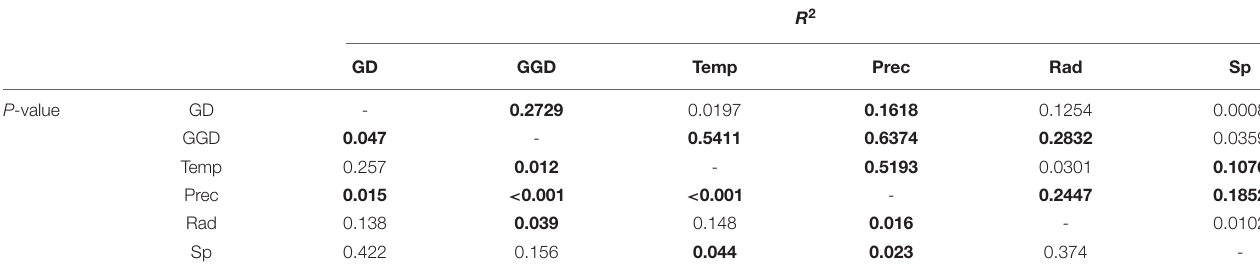
TABLE 4 | Matrix of the p -values and coefficient of determination ( R 2 ) of pairwise Mantel tests between distance matrices of different parameters. R 2 GD GGD Temp Prec Rad Sp